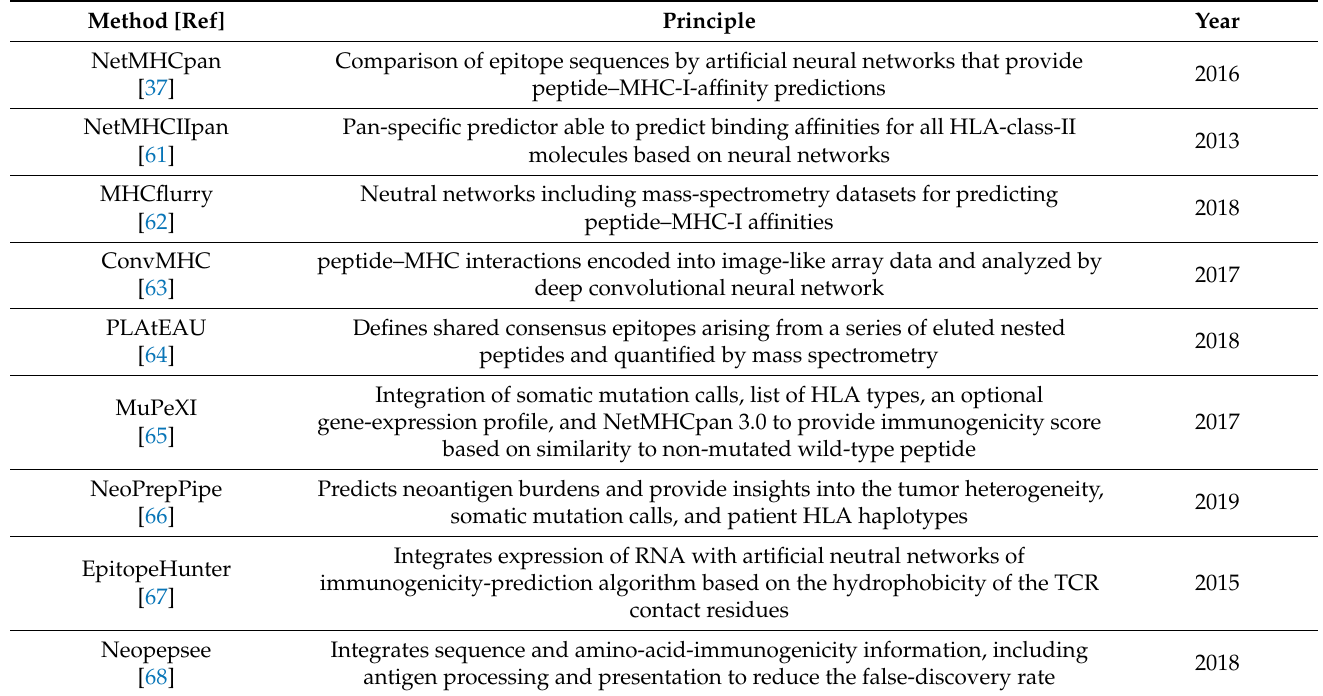
Table 1. Methods and platforms commonly used for predicting